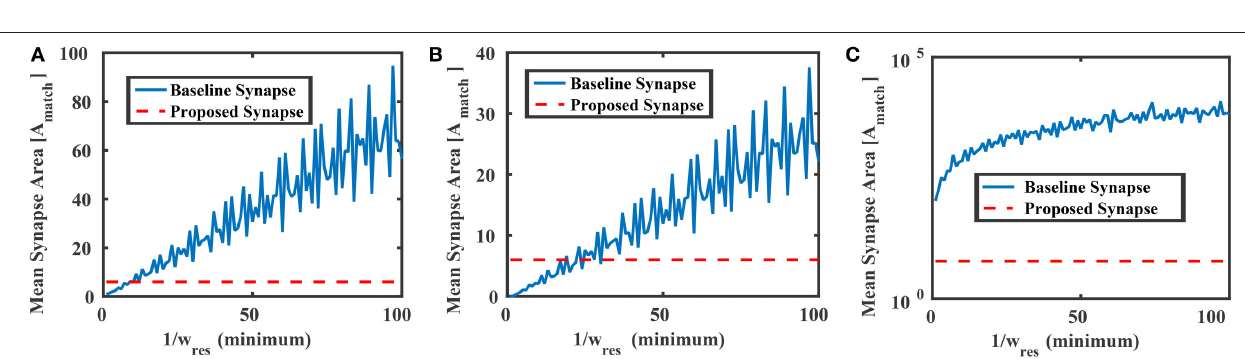
FIGURE 7 | Monte Carlo analyses showing the distributions of (A) random weights and (B) random biases associated with the synapse design in Figure 6B.